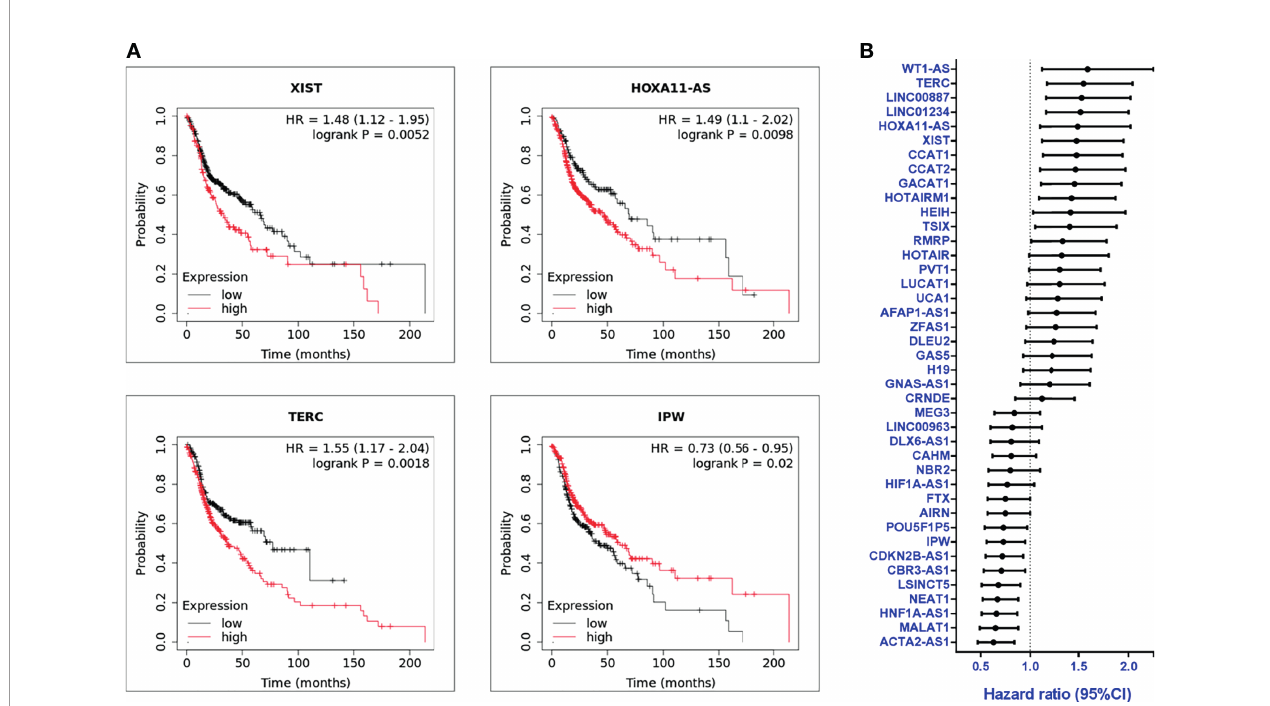
FIGURE 2 | Overall survival and prognosis analysis of pro fi led lncRNAs (A) Kaplan-Meier survival curve examples of dysregulated lncRNAs in HNC. Hazard ratios (HRs) were calculated with 95% con fi dence intervals (CI), and p-values ≤ 0.05 were considered signi fi cant. (B) HRs of 41 signi fi cantly dysregulated lncRNAs. A total of 41 lncRNAs were examined, post-exclusion of nine lncRNAs from the 55 highly dysregulated candidates with no information provided in KM